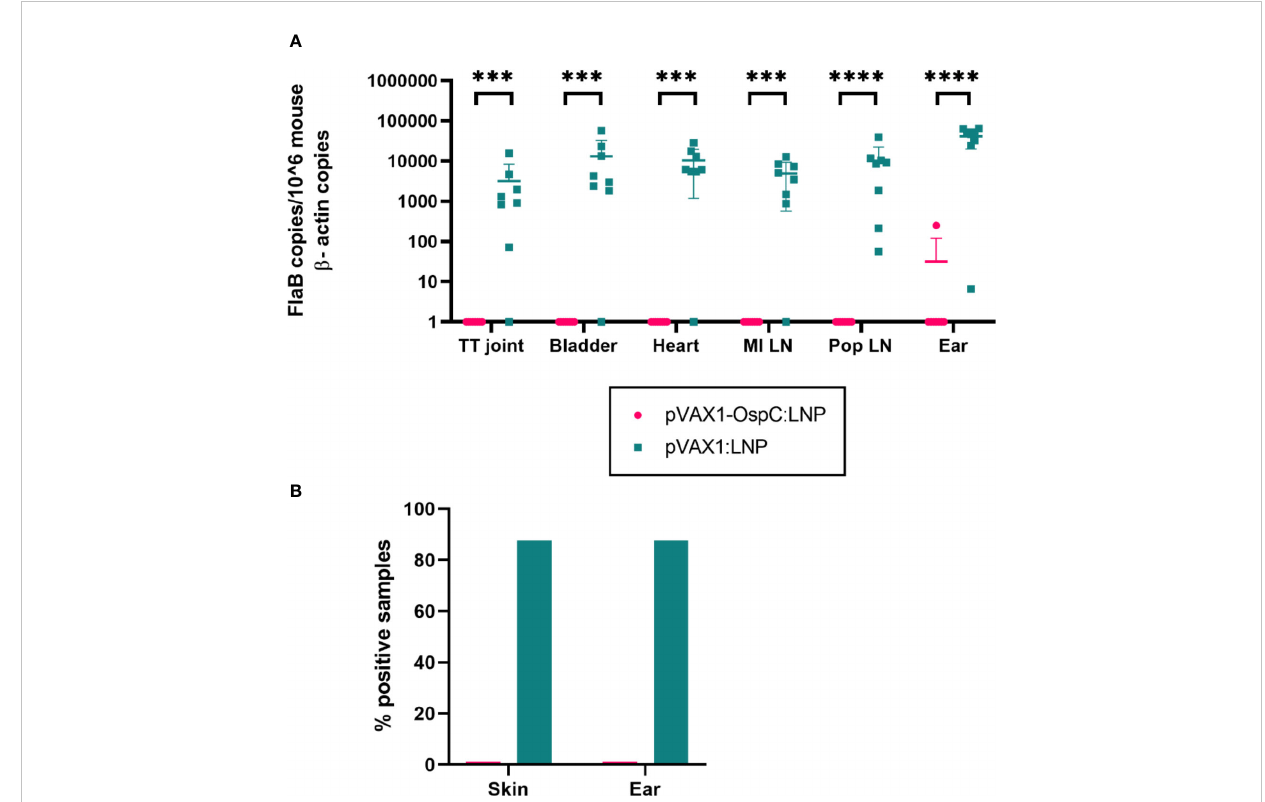
FIGURE 3 Vaccination with pVAX1-OspC prevents bacterial infection and dissemination. (A) qPCR was used to determine bacterial burden in a variety of mouse tissues 14 days after B. burgdorferi challenge. Bacterial burden is represented by copies of the B. burgdorferi FlaB gene per 1 × 10 6 mouse b -actin gene copies. Samples below the threshold of ampli fi cation were assigned a value of one. TT joint, Tibiotarsal joint; MI LN, medial iliac lymph node; Pop LN, popliteal lymph node. (B) The right ear and skin surrounding the bacterial injection site were collected at necropsy, placed in BSK-H growth media, and incubated for 14 days. Cultures were considered positive if at least one spirochete was identi fi ed by dark- fi eld microscopy across fi ve fi elds of view. Error bars represent standard deviation. *** p-value < 0.001, **** p-value <